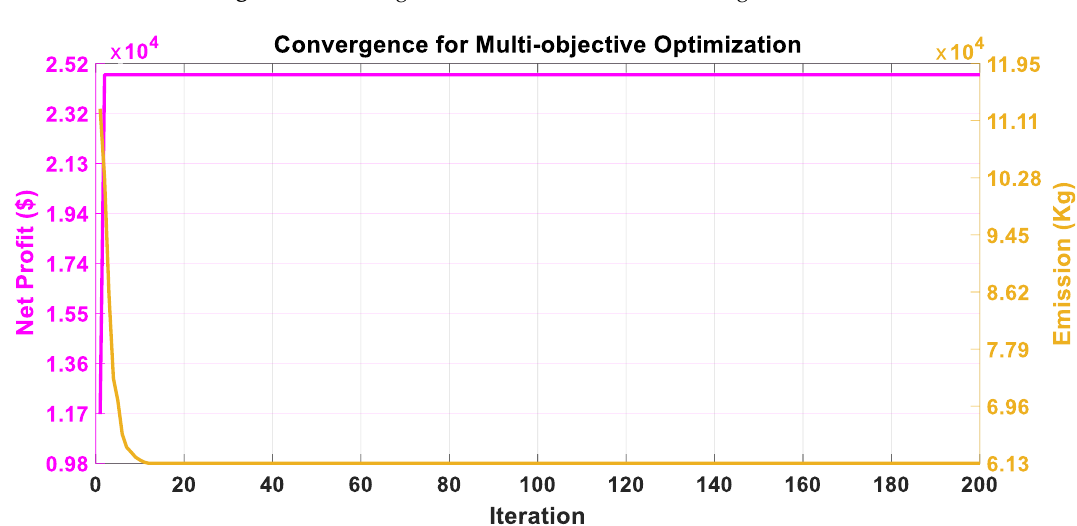
Figure 15. Convergence characteristics of the ACO algorithm for Case III.